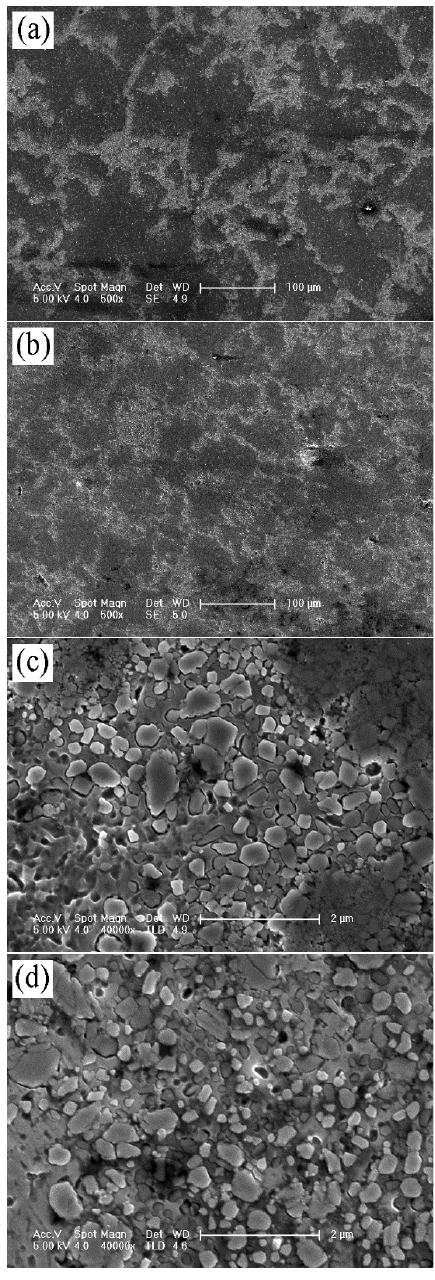
Figure 11: Microstructures of composites prepared by (a)(c) LSM method and (b)(d) electroslag melting. Table 3: Chemical compositions of 5 wt% TiB 2 /Al composites pre- pared by different processes